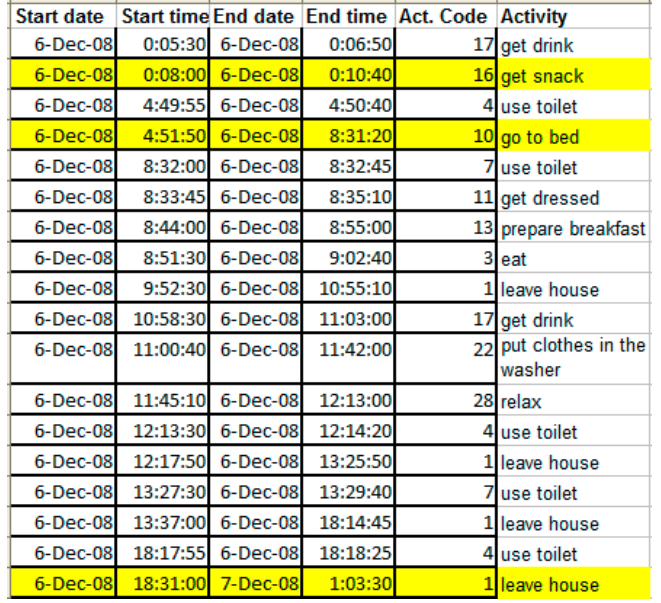
Figure 15. The activities from one of the days in the Kasteren C dataset, extracted from the annotations. Yellow highlights indicate unusual times for the respective activities.